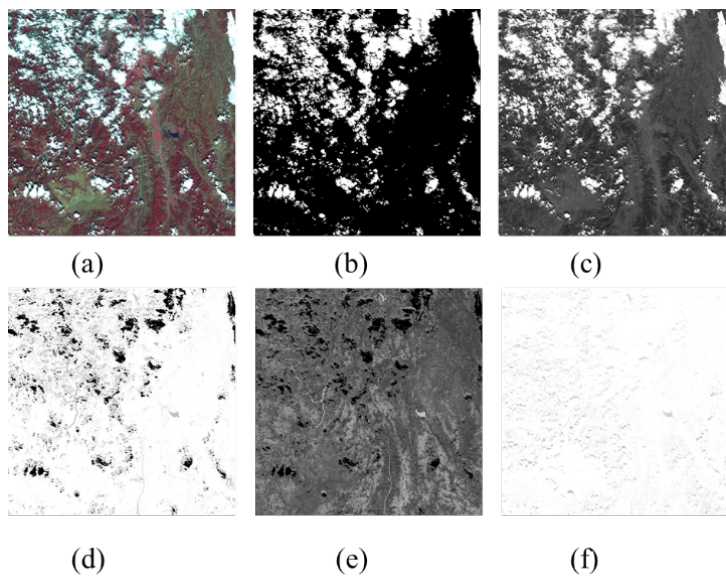
Figure 6. ( a )NIR-R-G image, ( b ) ground truth, ( c ) Dark channel image, ( d ) H component of hue, saturation, and intensity (HSI), ( e ) S component of HSI, and ( f ) I component of